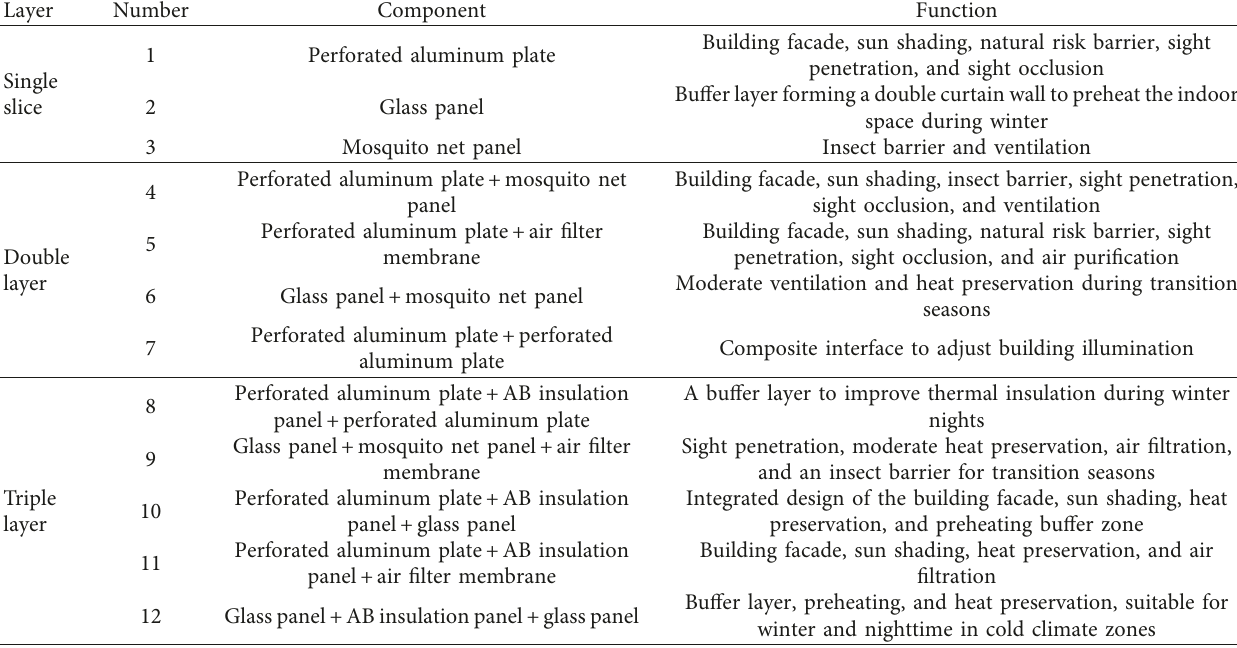
Table 1: Dynamic combinations of replaceable interface modules.